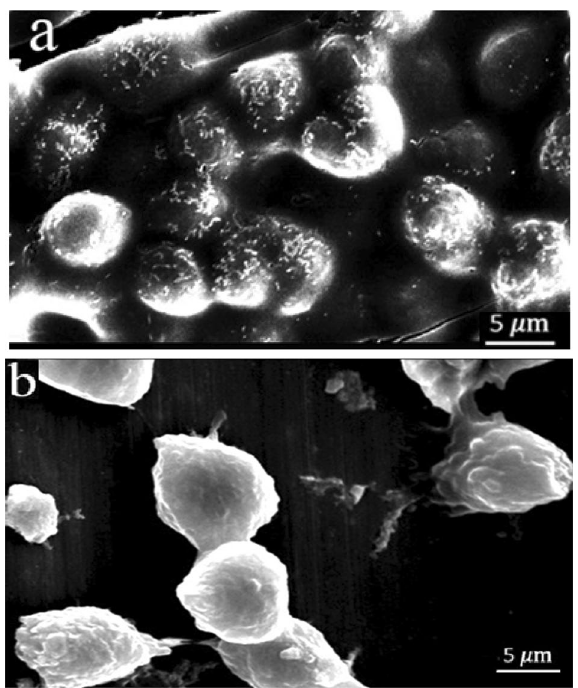
Figure 3. Electron microscopy images of the target and non-target cells in the vicinity of magnetite nanoparticles. ( a ) Binding of magnetite nanoparticles and MCF-7 cells through specific EP-CAM antibodies. ( b ) Nanoparticles are not bonded to L929